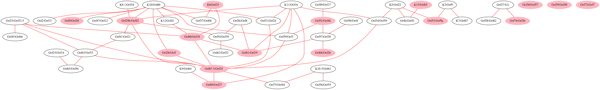
The alignment graph only containing aligned orthologous pairs and matched edges. Each node represents a pair of aligned ORFs and the orthologous pairs are shaded.